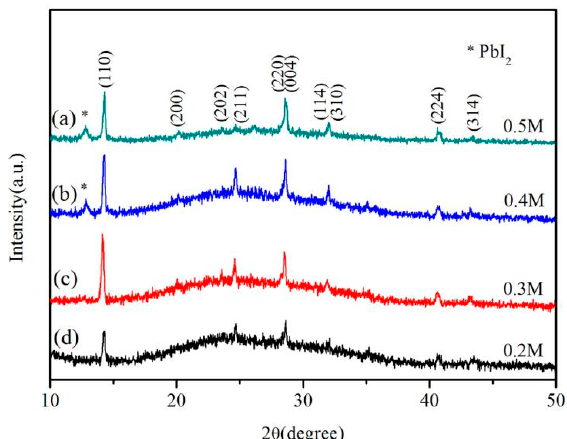
Figure 2. XRD patterns of perovskite nanowires synthesized with different PbI 2 precursor concentration of ( a ) 0.5 ML; ( b ) 0.4 M; ( c ) 0.3 M and ( d ) 0.2 M.